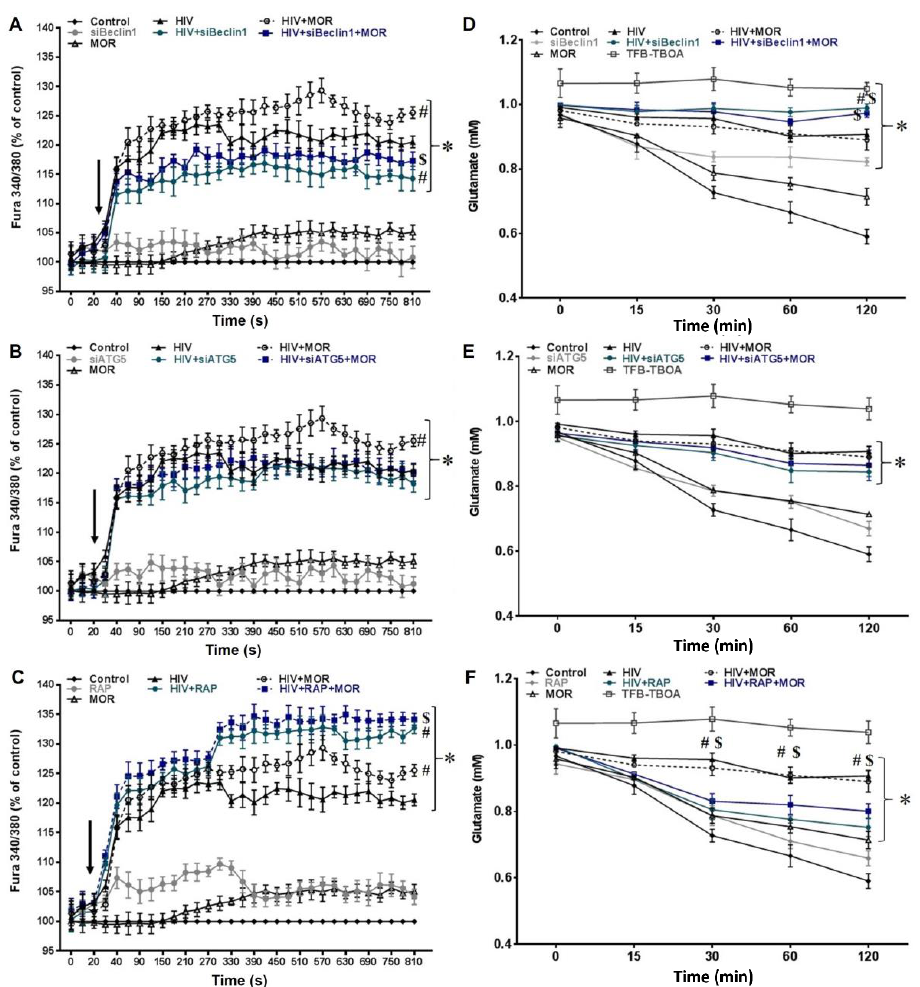
Figure 1. Intracellular calcium release and glutamate uptake are mediated by the autophagy pathway. ( A – C ) Effects of autophagy on [Ca 2+ ] i production in astrocyte cultures were assessed by fura-2AM at the indicated time points. Arrows represent the time of treatment with human immunodeficiency virus (HIV), morphine (MOR) alone (1 µM) or in combination, after 20 s of basal readings. Results represent the percentage of control values and are presented as the mean ± the standard error of the mean (SEM) of three independent experiments pre-treated with ( A ) siBeclin1, ( B ) siATG5 and ( C ) rapamycin in human astrocytes ( p < 0.05 * vs. Control, # vs. HIV, $ vs. HIV + MOR). ( D – F ) Human astrocytes infected with HIV alone or in combination with morphine were challenged with glutamate (1.0 mM) and levels of residual glutamate in the medium were measured at the indicated time points for experiments in which astrocytes were transfected with ( D ) siBeclin1, ( E ) siATG5 and pre-treated with ( F ) rapamycin. Gray line represents cells treated with the excitatory amino acid transporter inhibitor, (3S)-3-[[3-[[4-(Trifluoromethyl)benzoyl]amino]phenyl]methoxy]- L -aspartic acid (TFB-TBOA). Data are presented as the mean ± SEM of three independent experiments ( p < 0.05 * vs. Control, # vs. HIV, $ vs. HIV + MOR).